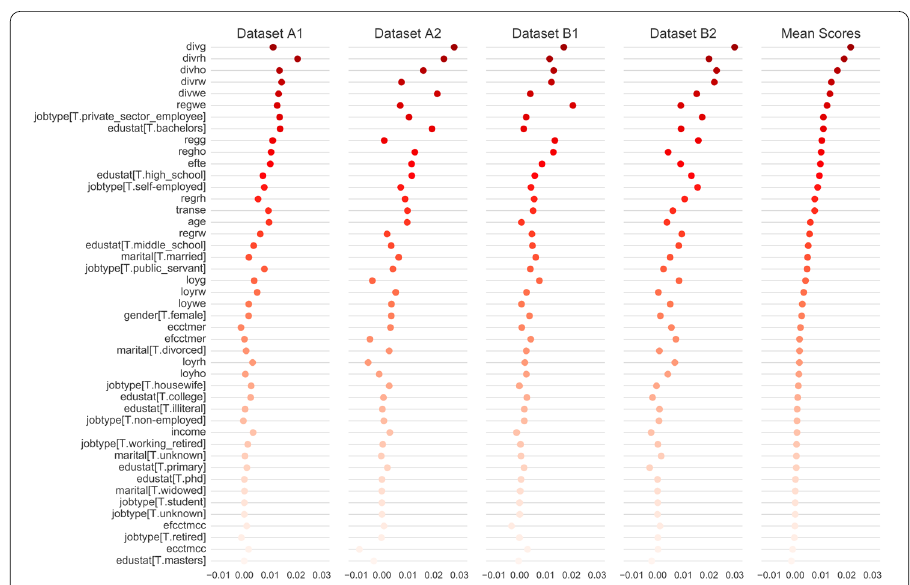
Figure 3 Feature Importance Analysis. Illustrated is the importance of the features which were calculated based on the mean decreasing values of area under ROC curve after randomly permuting the